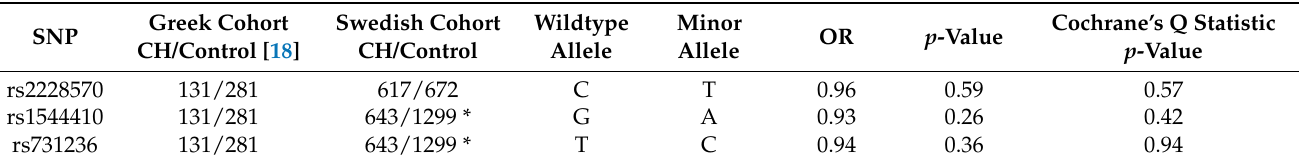
Table 3. Meta-analysis of vitamin D receptor single-nucleotide polymorphisms analyzed in a Greek and a Swedish cluster headache